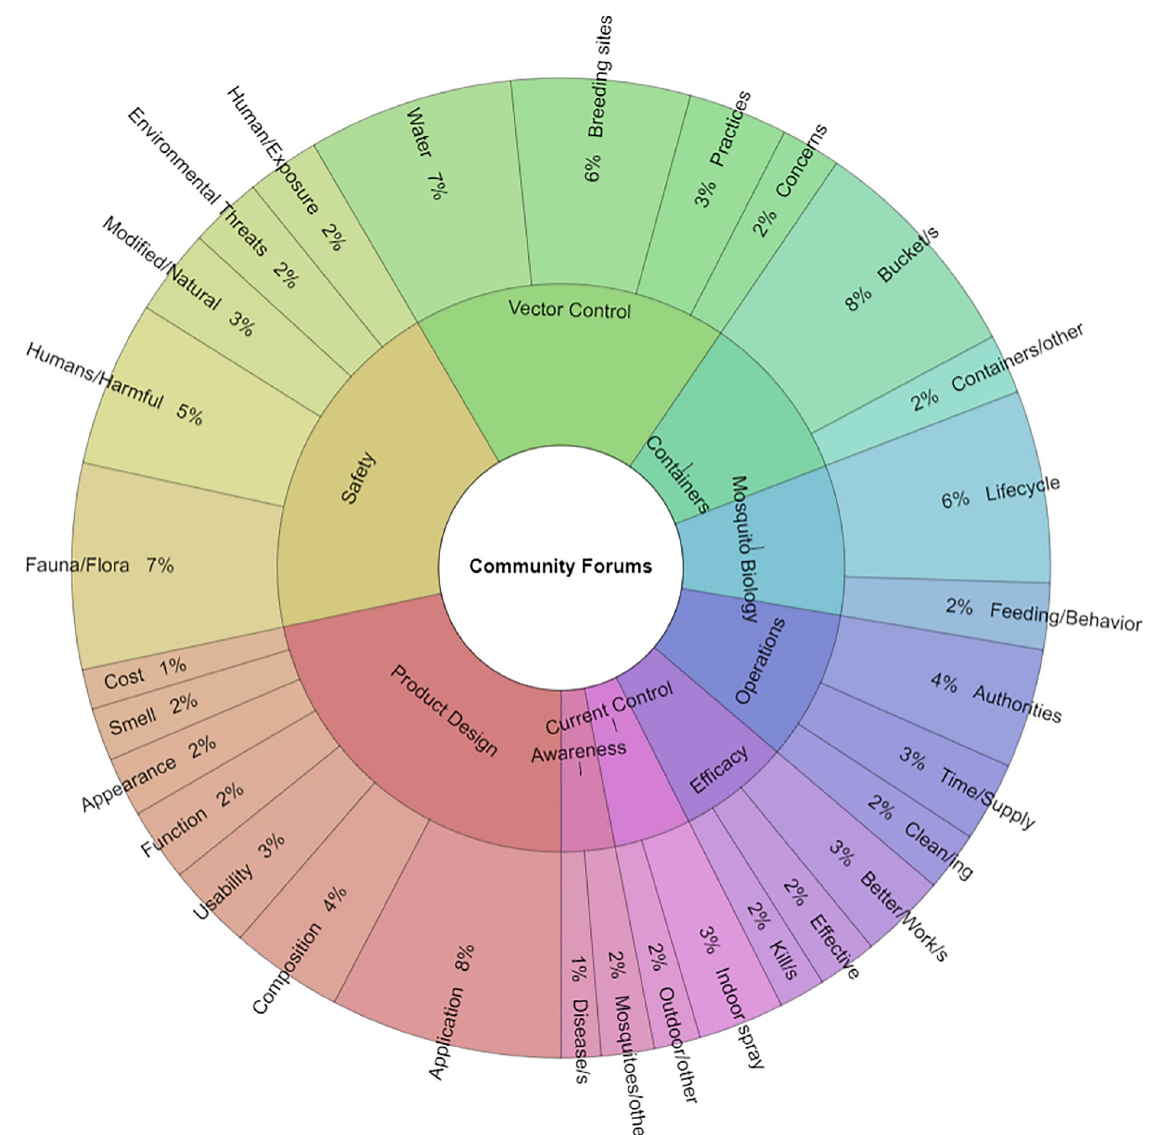
Fig 5. Krona chart detailing words used across the four community engagement forums. Keyword frequency of 457 identified words corresponding to nine themes derived from textual analysis of 5,246 words in the combined transcript from the four community engagement forums. The chart was generated with Krona Excel Template v.2.5